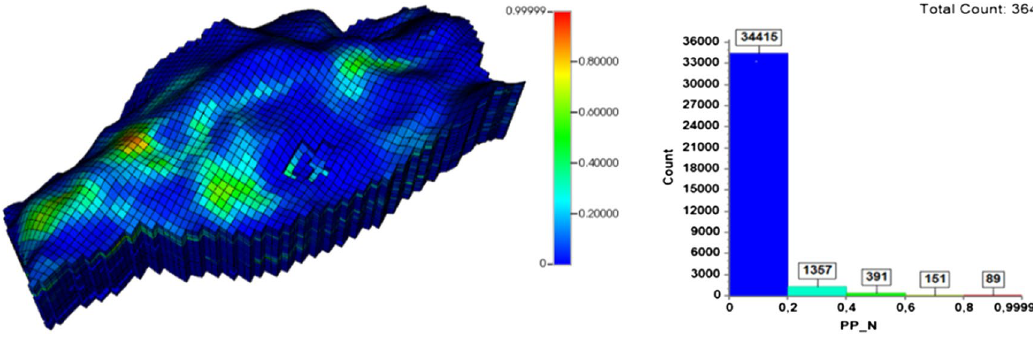
Fig. 2 Normalized PP i map (left) and its histogram for the active blocks